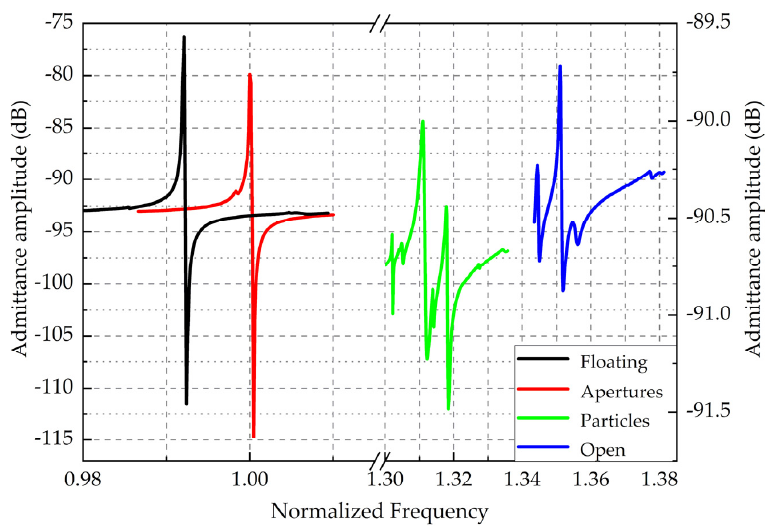
Figure 4. Simulated admittance amplitude spectra of the AlN LWRs with different surface structures.